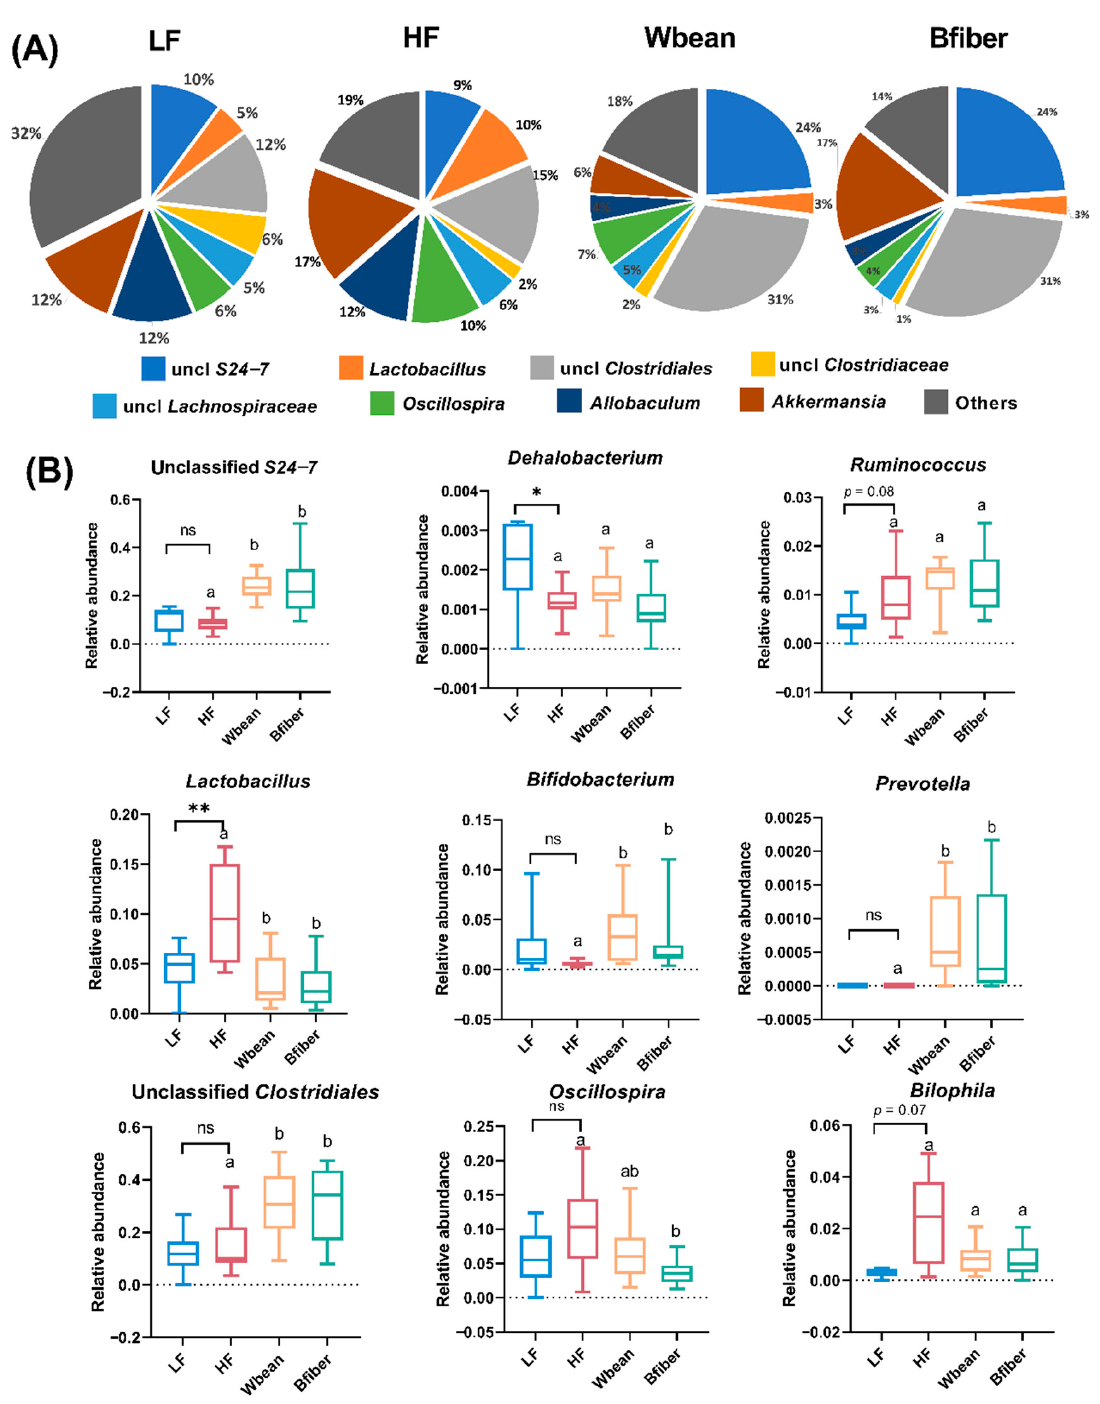
Figure 6. ( A ) Microbial profile at genus level and ( B ) relative abundance of genera showing a sig- nificant difference or tendency in the cecum of mice fed a low fat (LF), high fat (HF), whole brown bean (Wbean), or bean fiber (Bfiber) diet for 10.5 weeks. Values in the LF and HF groups were compared using Welch’s t -test (or Mann–Whitney test for nonparametric data). Values in the high fat groups, i.e., HF, Wbean, and Bfiber, were compared using one-way ANOVA (Welch’s ANOVA test for data with unequal SDs, or Kruskal–Wallis test for nonparametric data), followed by post hoc tests. Different lowercase letters above data for the HF setting groups indicate significant differences ( p < 0.05). ns: not significant. * p < 0.05, ** p < 0.01. The LF diet led to lower relative abundance of Proteobacteria compared with the HF diet ( p < 0.001). Both bean groups had higher abundances of Actinobacteria and Bac- teroidetes compared with the HF group ( p < 0.05). The Bfiber diet resulted in a tendency